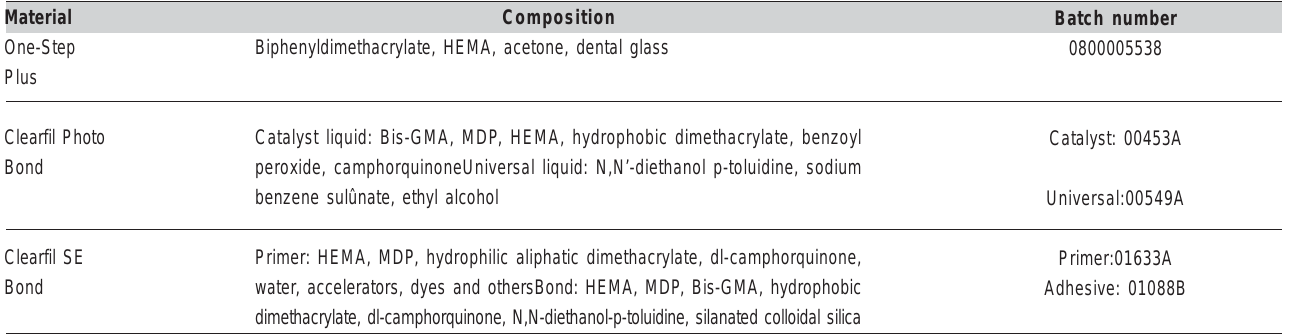
Table 1. Composition and batch number of the adhesive systems used in this study (information supplied by the MSDS of each